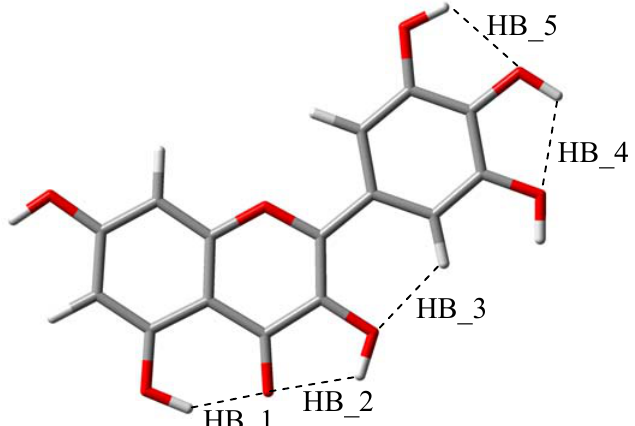
Figure 4. Sites for intramolecular hydrogen bonding in the studied